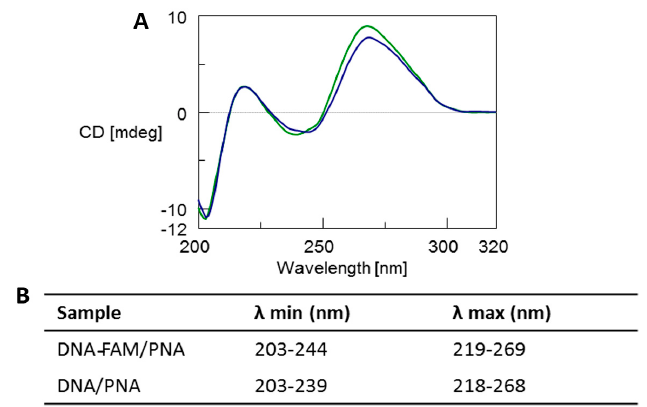
- Figure 2. ( A ) Overlapped CD spectra of DNA-FAM / PNA (blue line) and DNA / PNA (green line) mixtures after annealing in 100 mM PBS at pH 7.0. ( B ) λ values of CD minima and maxima.